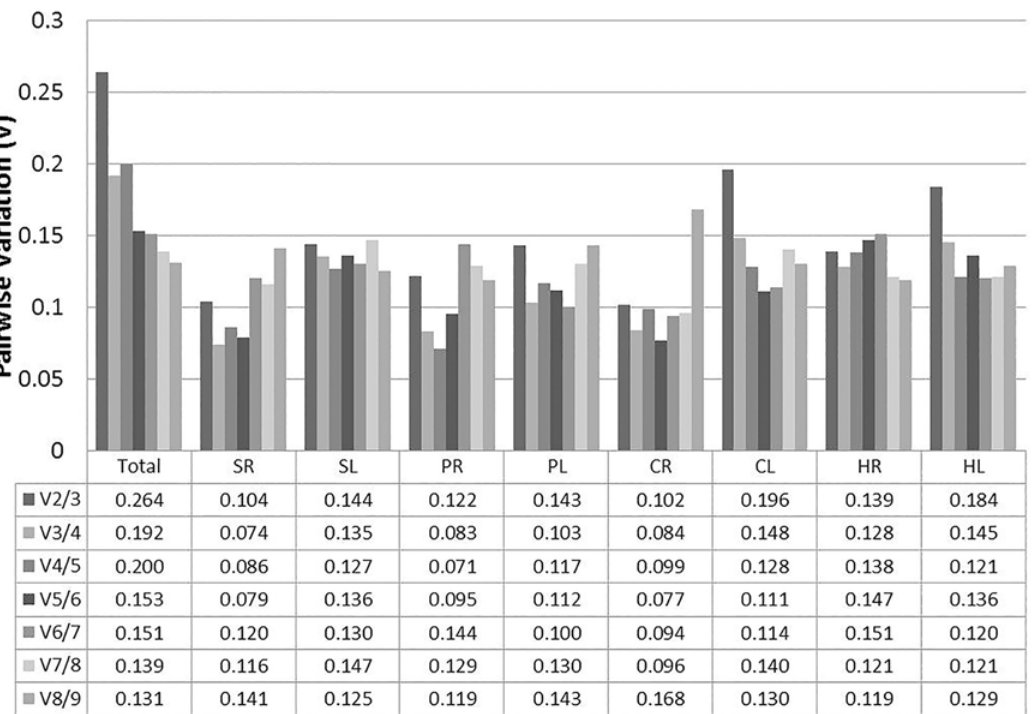
Fig 4. Pairwise variation (V) of the candidate reference genes calculated by geNorm. V n /V n+1 values were used for decision of the optimal number of reference